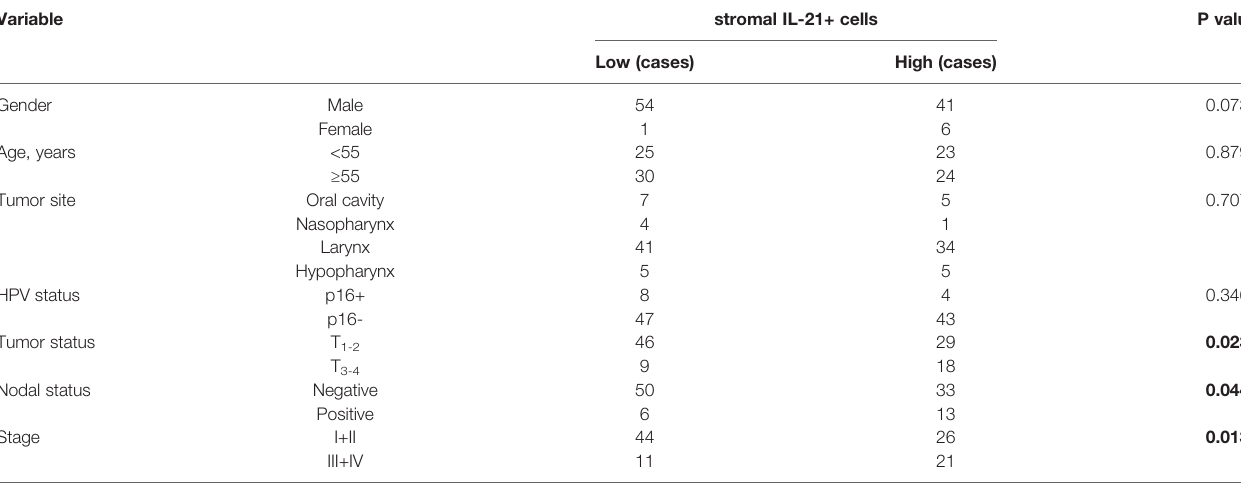
TABLE 2 | Relationships between tumor stromal IL-21 + cells and clinical variables. Variable